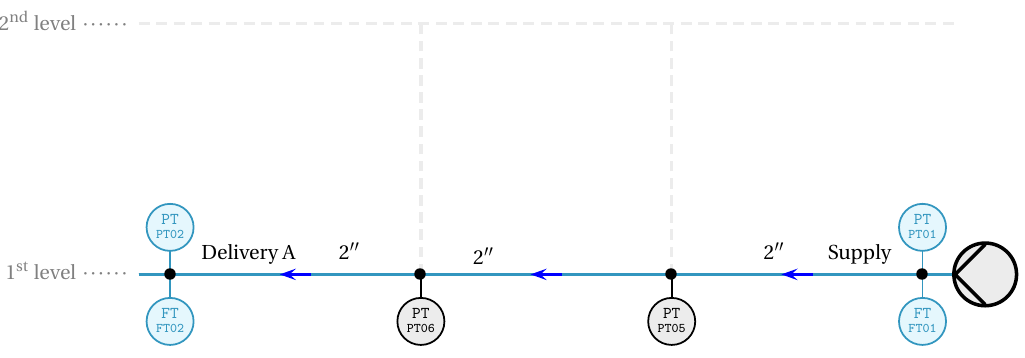
Figure 2. Simple pipe